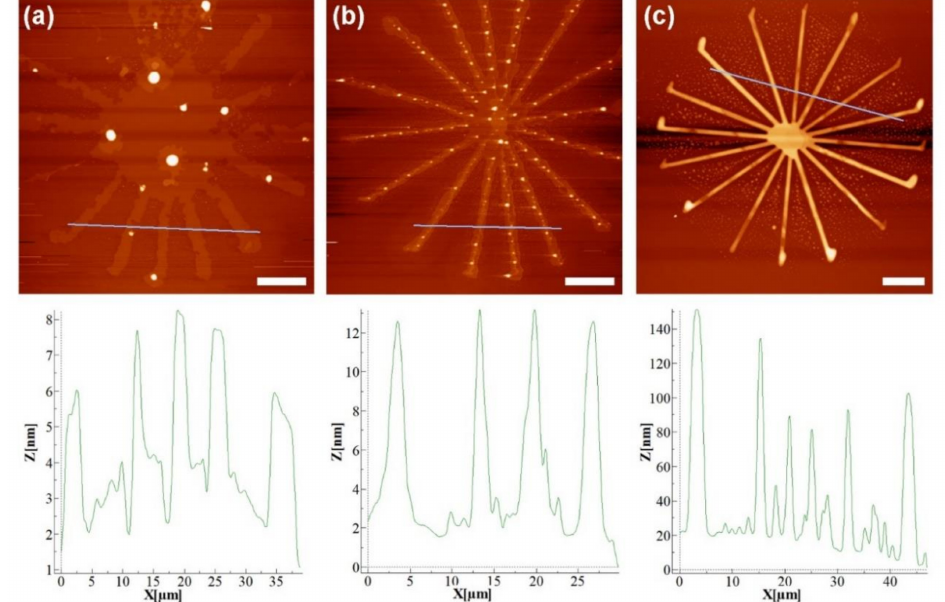
Figure 2. Typical outcomes of L-DPN on the di ff erent substrates. AFM images (topography, tapping mode) of star-shaped lipid structures on ( a ) glass, ( b ) SiO x / SEEC substrate and ( c ) block-type MPC copolymer. The profile lines in the bottom row show the respective height profile corresponding to the blue line in the AFM images. Scale bar equals 10 µ m in all